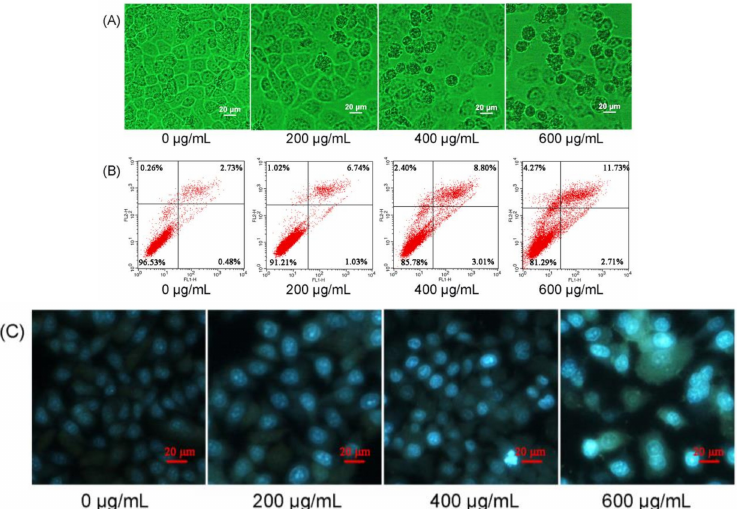
Figure 5. CMPs-4 induced the apoptosis of human esophagus cancer Eca-109 cells. Inverted light micrographs of Eca-109 cells showing morphological changes of cells treated with CMPs-4 for 24 h ( A ). Quantitative analysis of CMP-4-induced apoptotic cells measured using Annexin V-FITC and PI staining ( B ). Fluorescence micrographs of CMP-4-treated Eca-109 cells stained with Hoechst 33258 ( C ). The CMP-4-induced cell apoptosis was further evaluated and quantified using flow